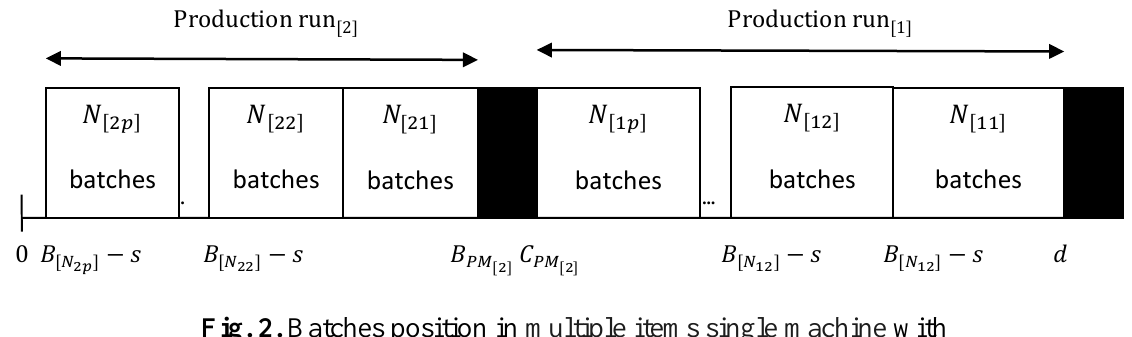
Fig. 2. Batches position in multiple items single machine with two production runs in total actual flow time